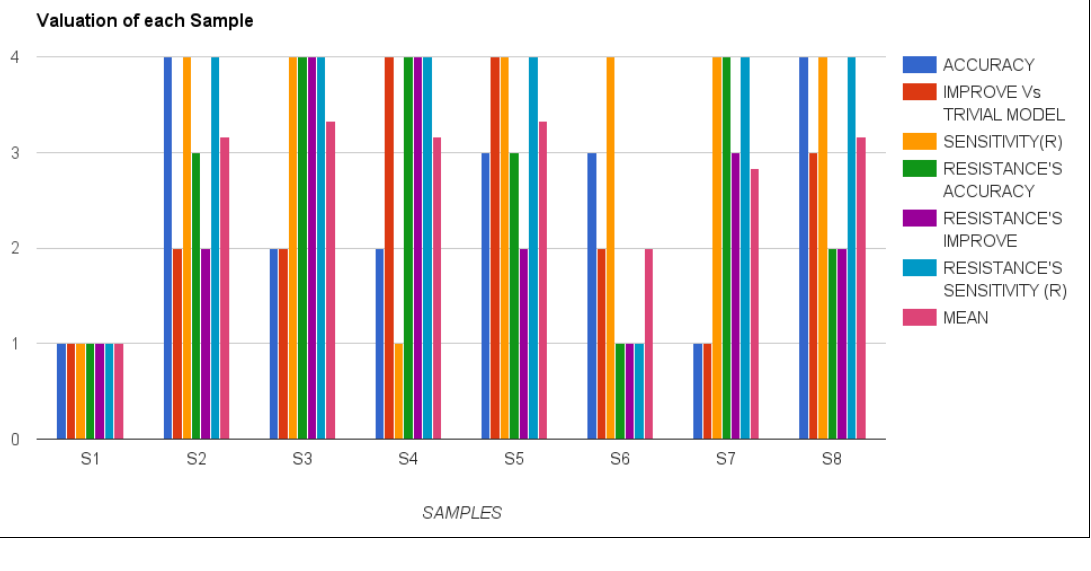
Fig. 7. State diagram of the decision tree based intelligent